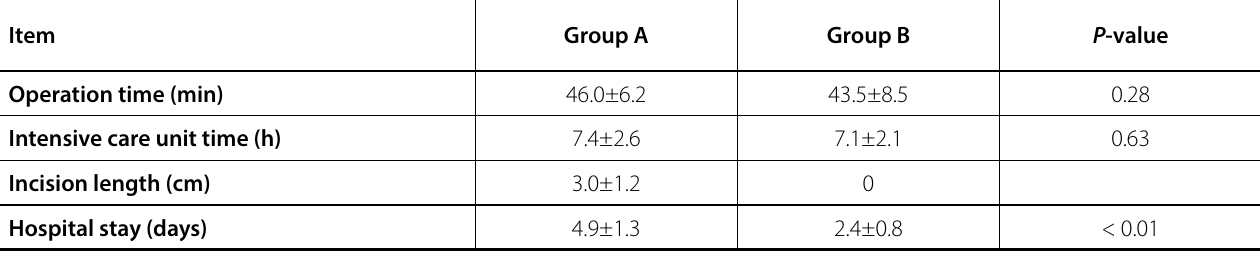
Table 2 . Perioperative and postoperative data comparison between two groups of patients.